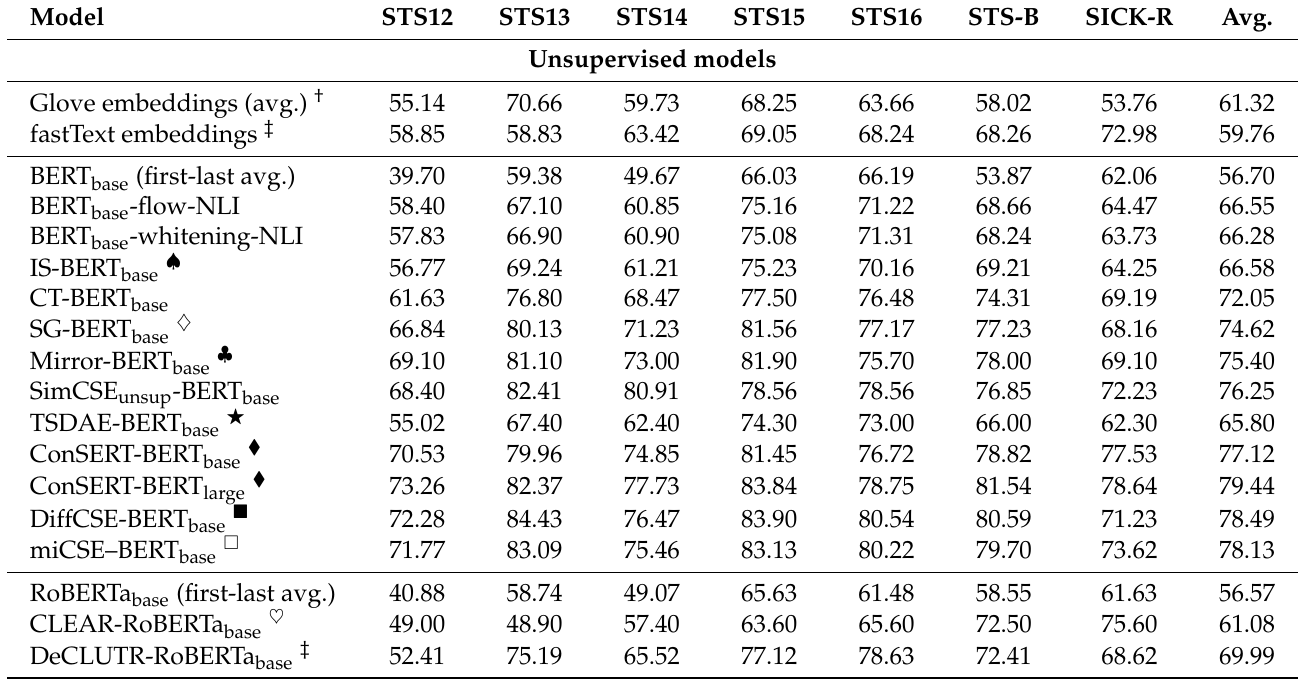
Table 4. Assessment results on the seven STS tasks. Spearman’s rank correlation as ρ × 100 is